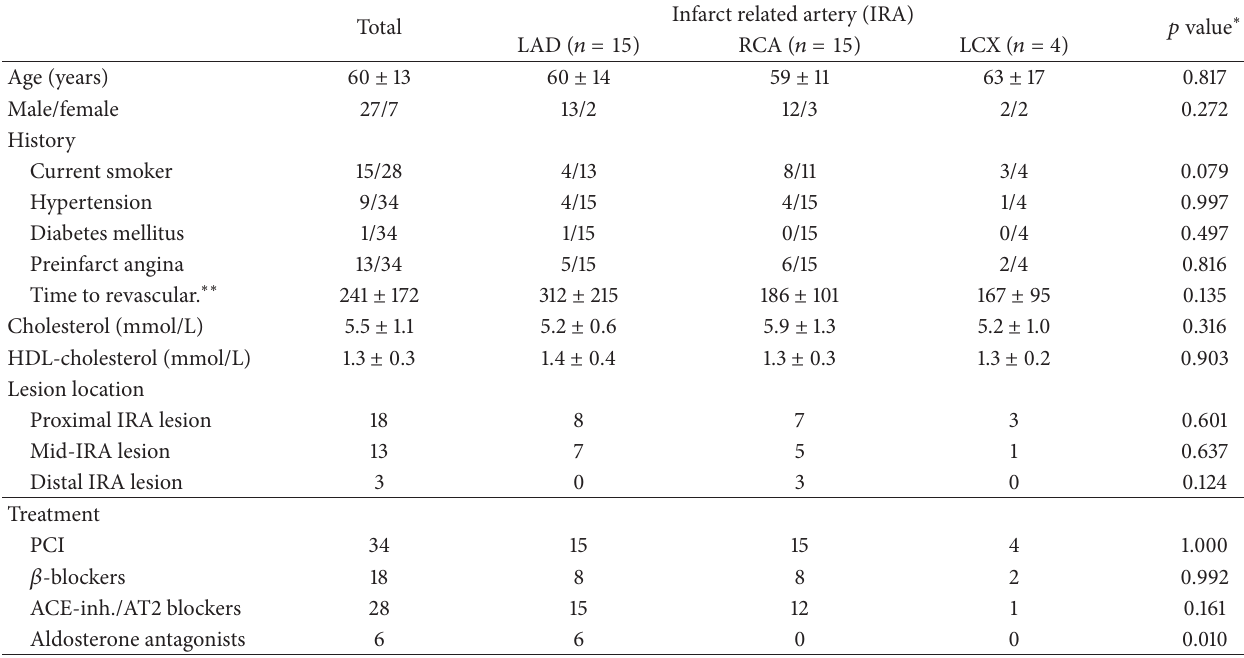
Table 1: Baseline characteristics of the study population ( 𝑛 = 34 ) with single-vessel coronary artery disease.